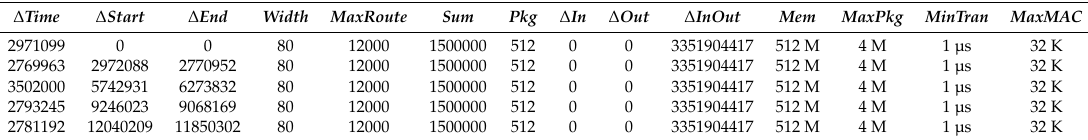
Table 1. Queue data after